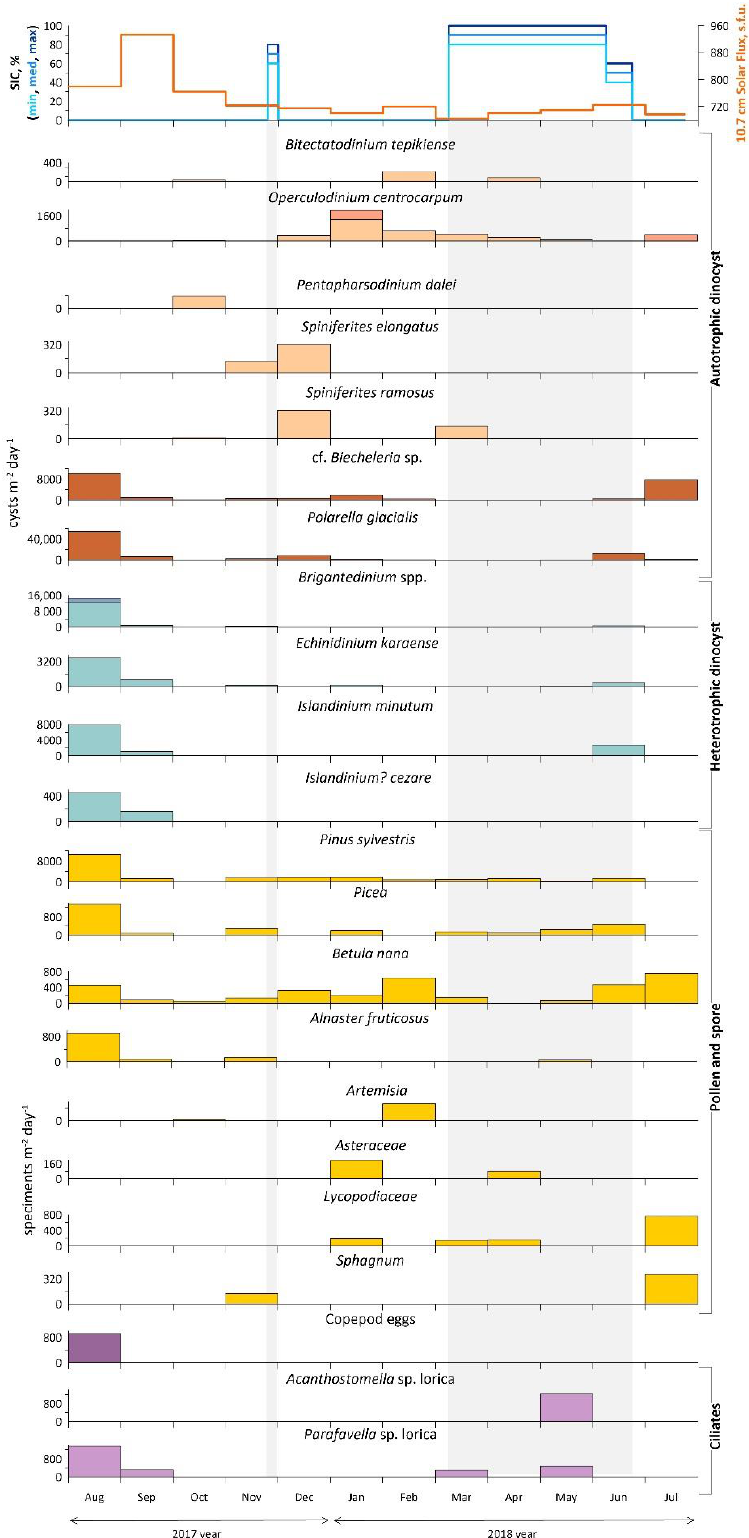
Figure 7. Annual dinoflagellate cyst fluxes at the mooring station of AMK-5565 ADOS. Phototrophic taxa are indicated in orange and heterotrophic in blue, while darker shades of orange and blue indicate the proportion of cysts found with cell content. Pollen and spore flux is shown in yellow and organic-walled remains flux in purple. The top shows the sea-ice cover (concentration in %), and solar flux, light gray rectangles mark the ice-covered season (SIC > 50%).